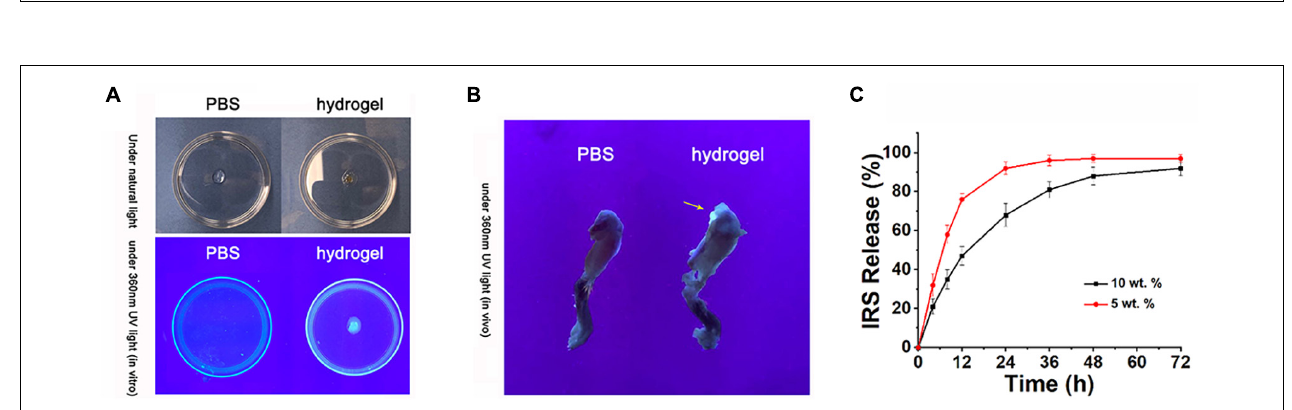
FIGURE 5 | Intraarticular injection of r-IRS protein with a nano-hydrogel. (A,B) The injectable citrate-presenting polyester hydrogel can be detected under 360 nm UV light both in vitro and in vivo . (C) rIRS release profile from hydrogel.